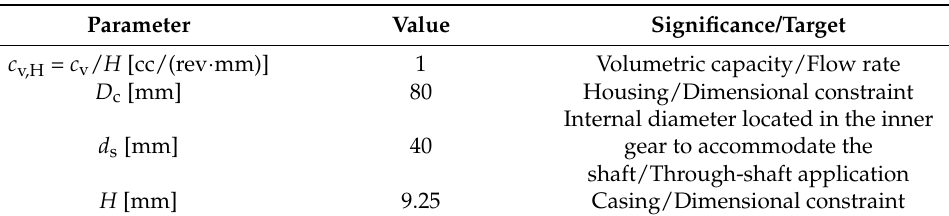
Table 3. D80d40cv1 benchmark gerotor. (Please refer to Nomenclature section and Figure 2).